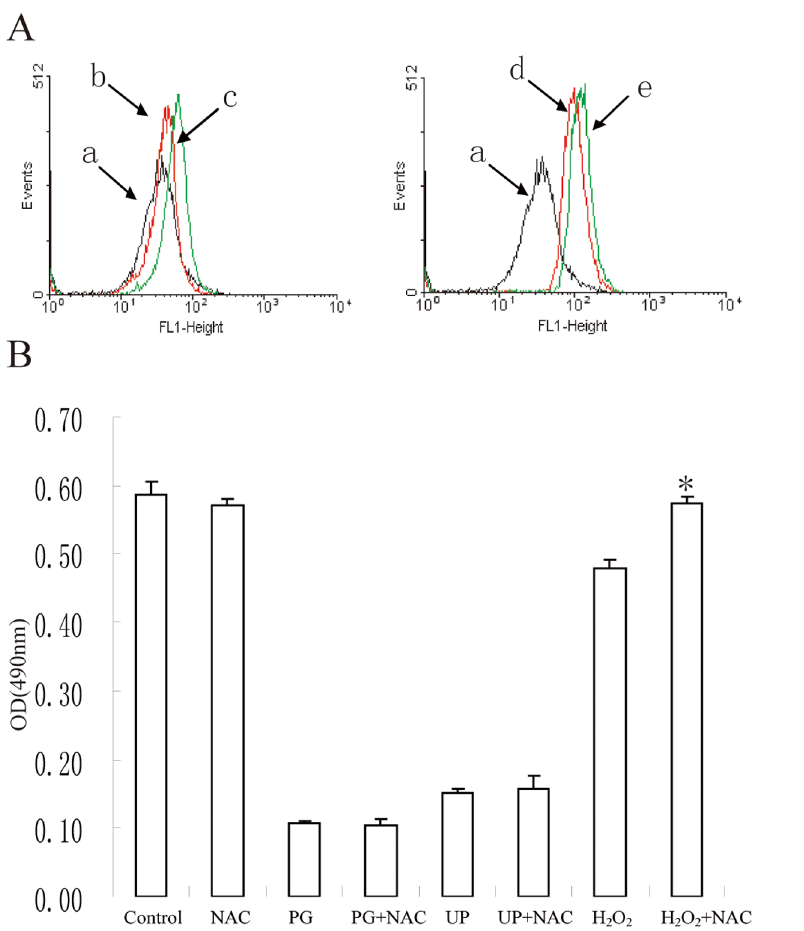
Figure 6. UP causes ROS generation, which is most likely not involved in UP-induced apoptosis. A. P388 cells were treated with 0.05 m M UP for 1 h, and stained with DCFH (10 m M). Fluorescence was measured by flow cytometry. a, DMSO + DCFH; b, 0.05 m M PG; c, 0.05 m M PG + DCFH; d, 0.05 m M UP; e, 0.05 m M UP + DCFH. B. P388 cells were pretreatment with or without NAC (0.5 mM) for 1 h, then cells were co- incubated with PG (0.05 m M ), UP (0.05 m M) and H 2 O 2 (0.4 mM) for 72 h. *, P , 0.05, H 2 O 2 vs (H 2 O 2 +